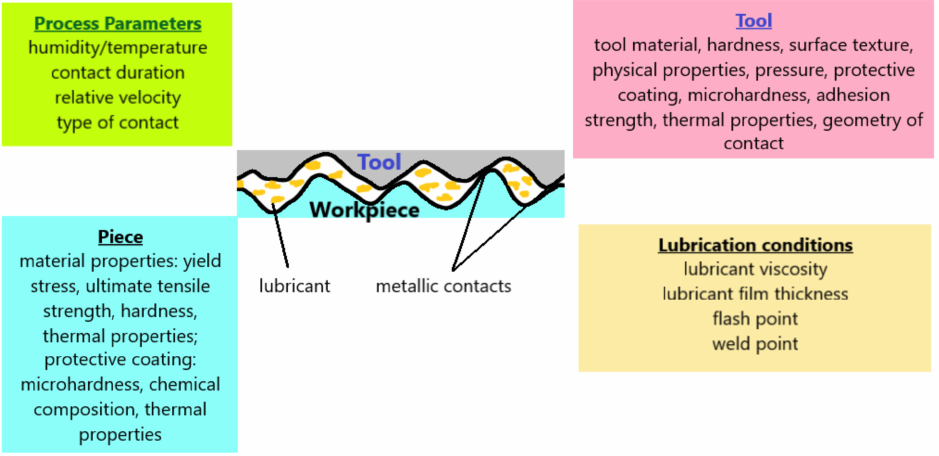
Figure 2. Parameters that can influence the friction in metal forming.